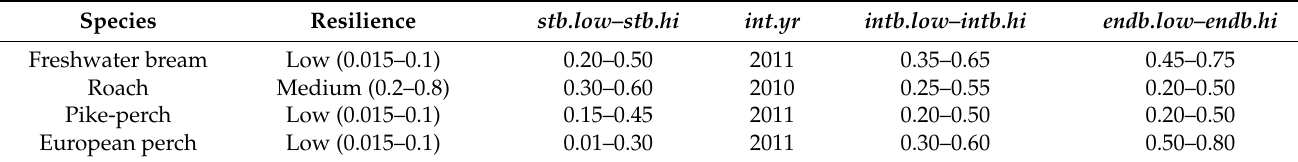
Table 4. CMSY model input parameters